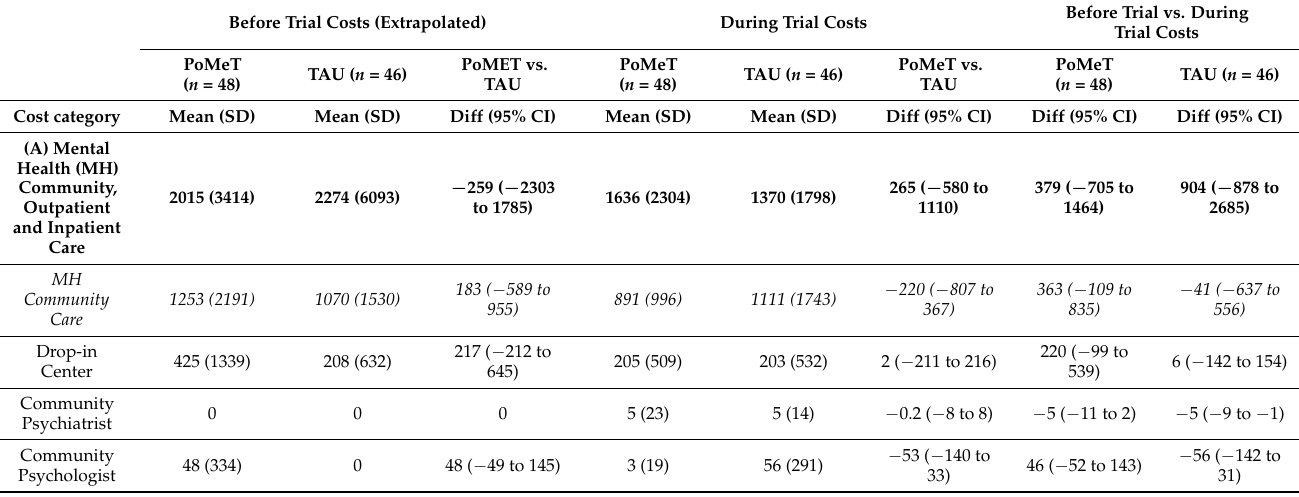
Table 3. Cost results (in GBP, for year